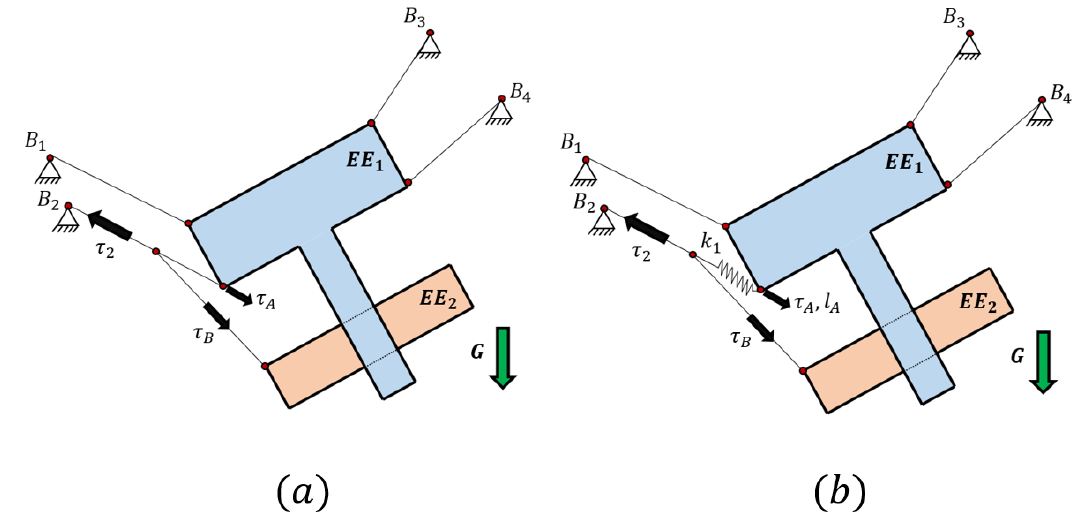
Figure 2. ( a ) Example of a cable acting on the two bodies of the end effector directly. In this case, the first body can be controlled in its three dof by using the four actuated cables. However, if the cable is not elastic, the second body cannot have its movement controlled as it is dependent on the position of the first body with respect to the anchor B 4 ; ( b ) Example of a cable acting on the two bodies of the end effector. The elongation of the first branch of the cable can modified by using a spring ( k 1 ). In this way, the relative position of the second body with respect to the first one can be controlled with the tension τ 2 . The value of τ A depends on the position desired for the second body but is compensated for by the three cables that can act on the first end effector in order to have control of the three dof of the first body and the control of the relative position of the second body.